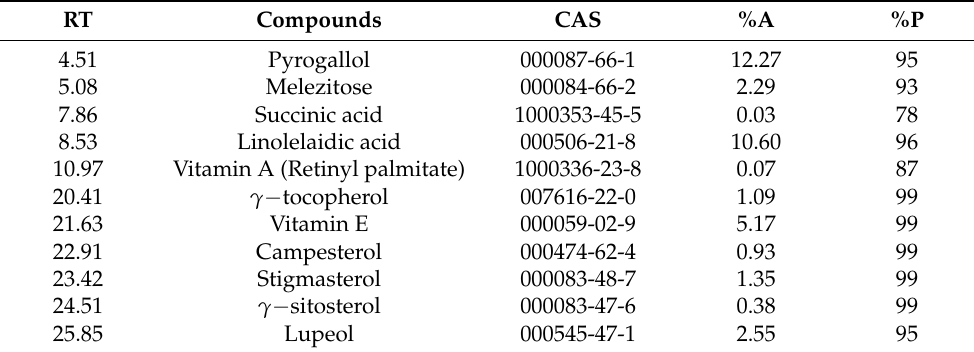
Table A1. Chemical composition of mango peel